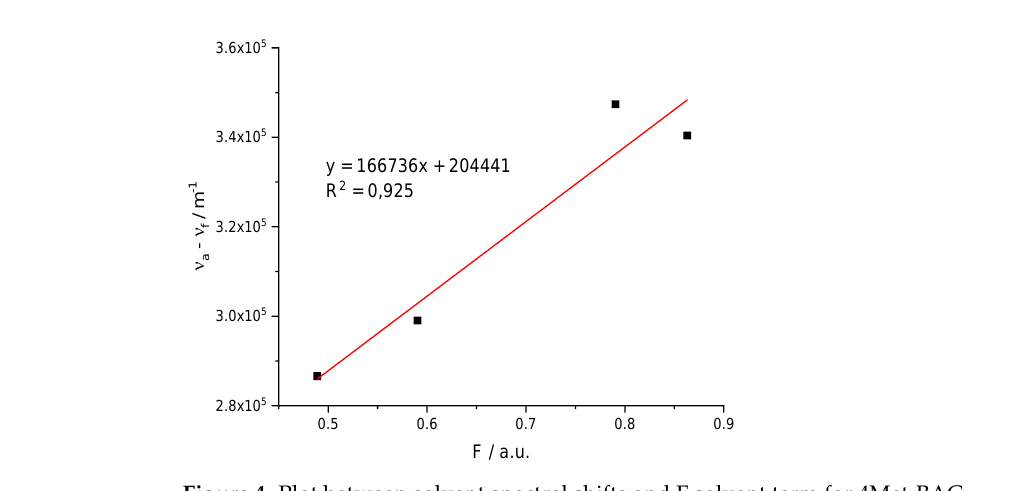
Figure 4. Plot between solvent spectral shifts and F solvent term for 4Met-BAC.